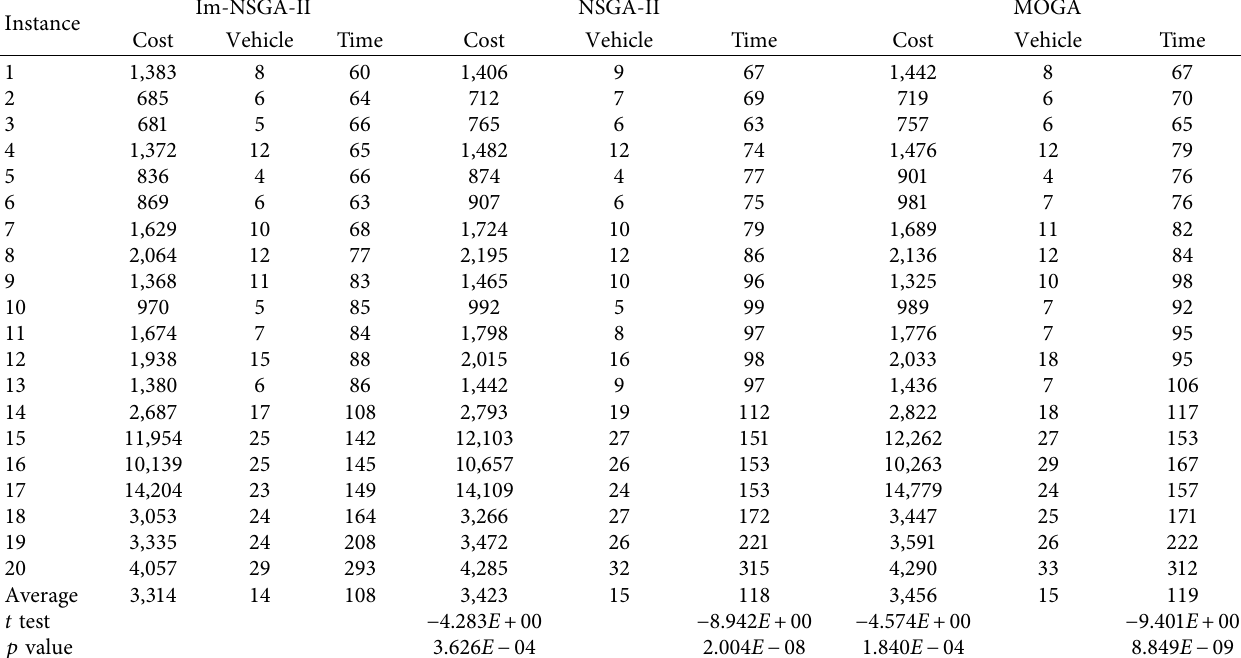
Table 6: Comparative results of three